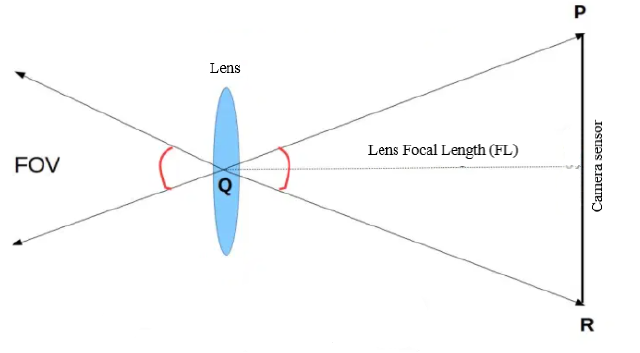
Figure 6. Geometry field of